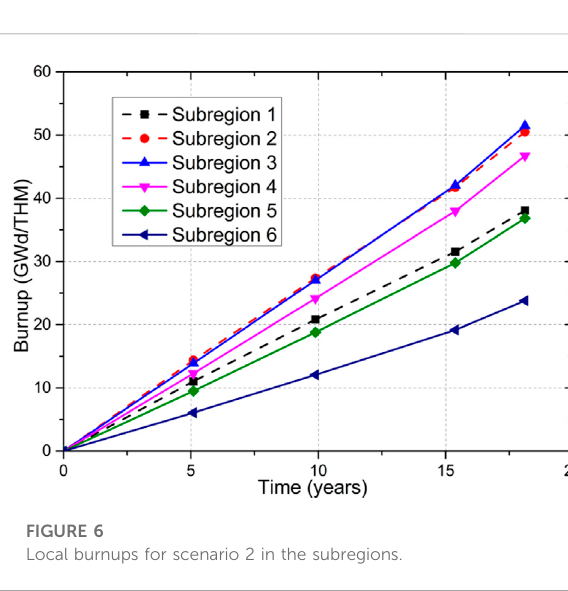
FIGURE 6 Local burnups for scenario 2 in the subregions.